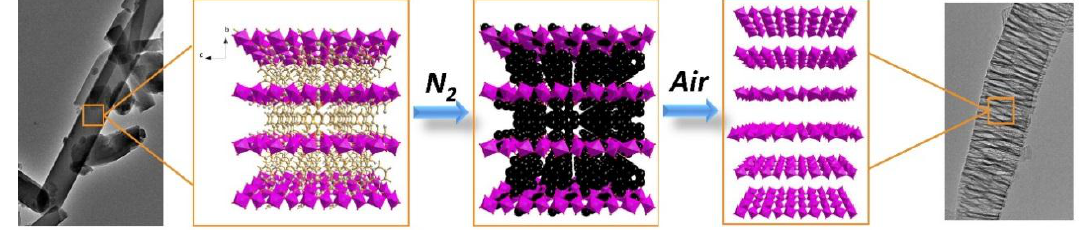
Scheme 1 The transformation process from Al-NDC precursor to Al 2 O 3 -Spongy by two-step pyrolysis.